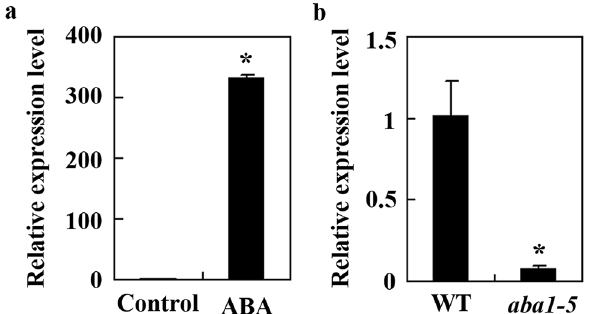
Figure 2. Expression of AITRL in response to ABA treatment. ( a ) Expression of AITRL in response to ABA. Twelve-day-old Col wild type seedlings were treated with 50 µM ABA or solvent methanol as a control for 4 h. Total RNA was isolated and qRT-PCR was used to examine the expression of AITRL . The expression of ACT2 was used as an inner control, and the expression level of AITRL in the control sample was set as 1. Data represent the mean ± SD of three replicates. *Significantly different from the control (p < 0.0001). ( b ) Expression of AITRL in the aba1-5 mutants. Total RNA was isolated from 12-day-old L er wild type and aba1-5 mutant seedlings, and qRT-PCR was used to examine the expression of AITRL . The expression of ACT2 was used as an inner control, and the expression level of AITRL in the wild type seedlings was set as 1. Data represent the mean ± SD of three replicates. *Significantly different from the wild type (p < 0.005).